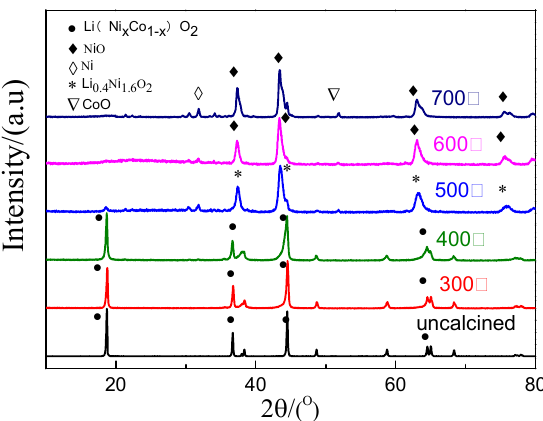
Figure 4. TG and DSC curves of the cathode active material: ( a ) 25–500 °C and ( b ) 25–750 °C. The XRD patterns of the spent cathode active materials calcined at different temperatures for 2 h are shown in Figure 5. The cathode active material did not decompose, and it remained as lithium nickel cobalt oxide Li(Ni x Co 1−x )O 2 at a temperature below 400 °C. However, it began to decompose and form Li 0.4 Ni 1.6 O 2 at 400 °C < T ≤ 500 °C. Furthermore, the cathode active material decomposed into NiO, CoO, and other substances at above 500 °C. It indicates that the high temperature destroyed the layered structure of the active material. There was no layered Li(Ni x Co 1−x )O 2 phase in the spent cathode active material at above 600 °C.